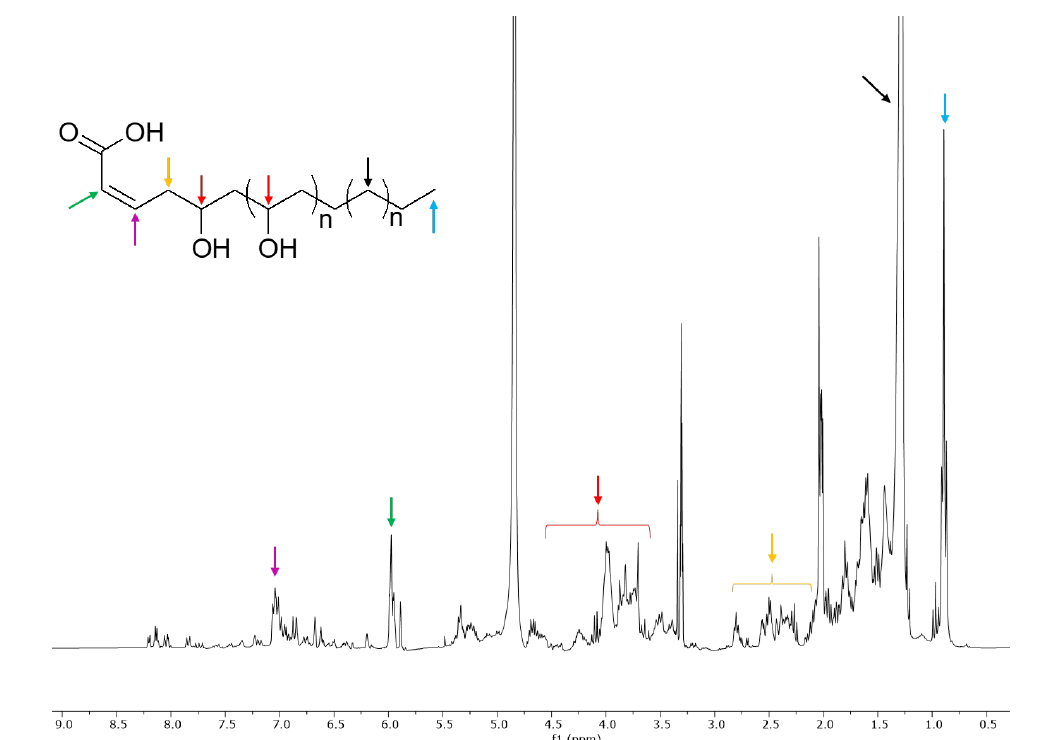
Figure 6. 1 H-NMR spectrum of the OdE fraction. A tentative general structure for the oxylipins is proposed, and diagnostic signals are indicated by colored arrows.